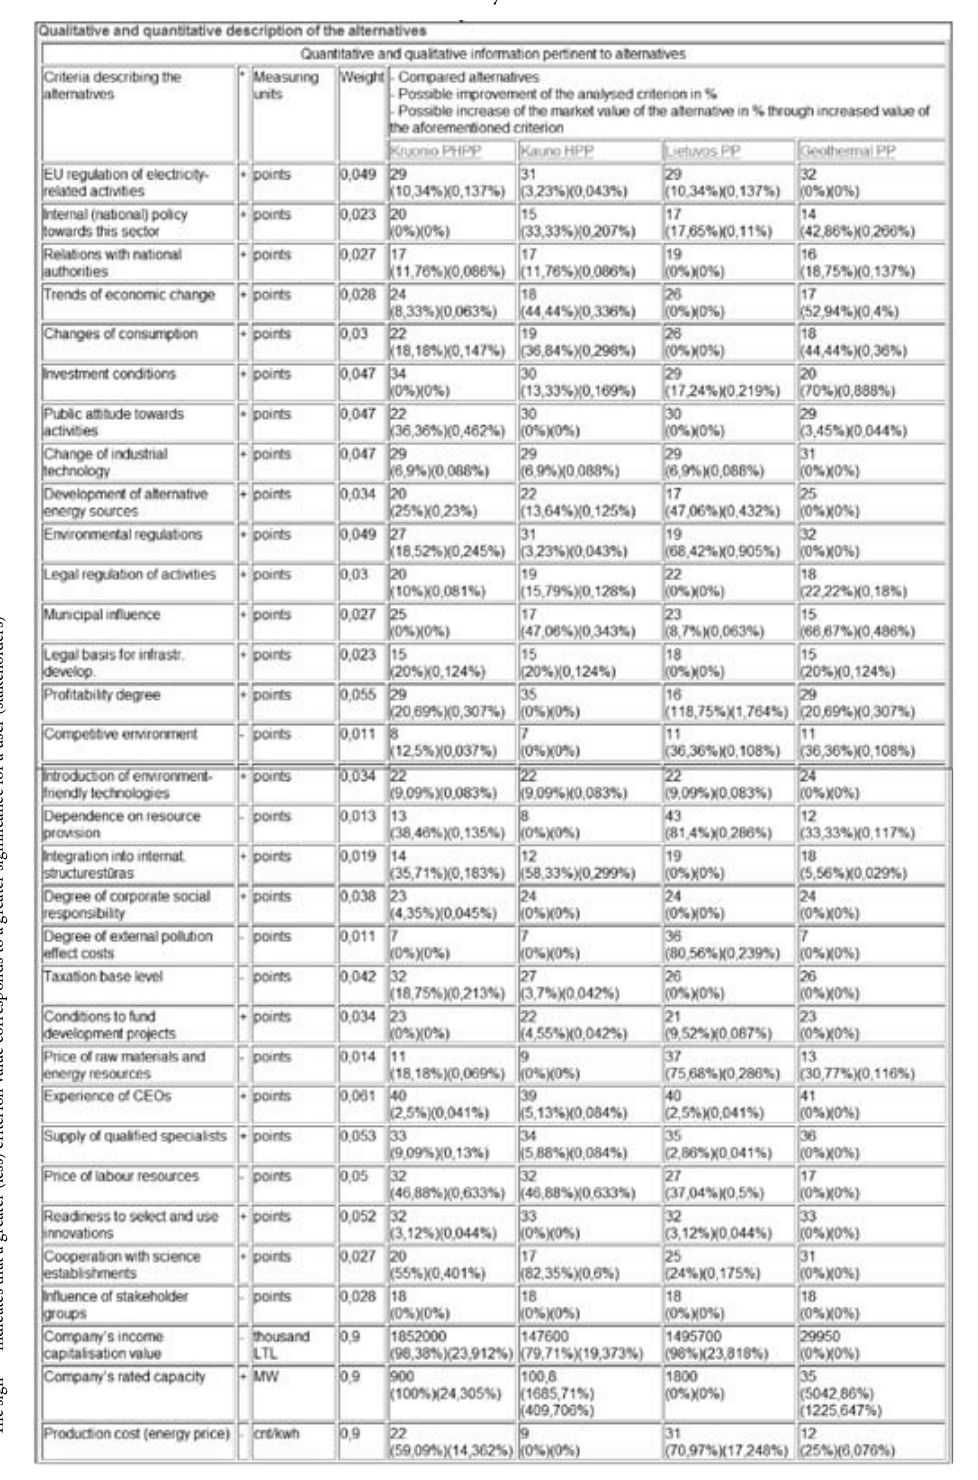
table 11. Recommendations in the ESIAPVN-DS